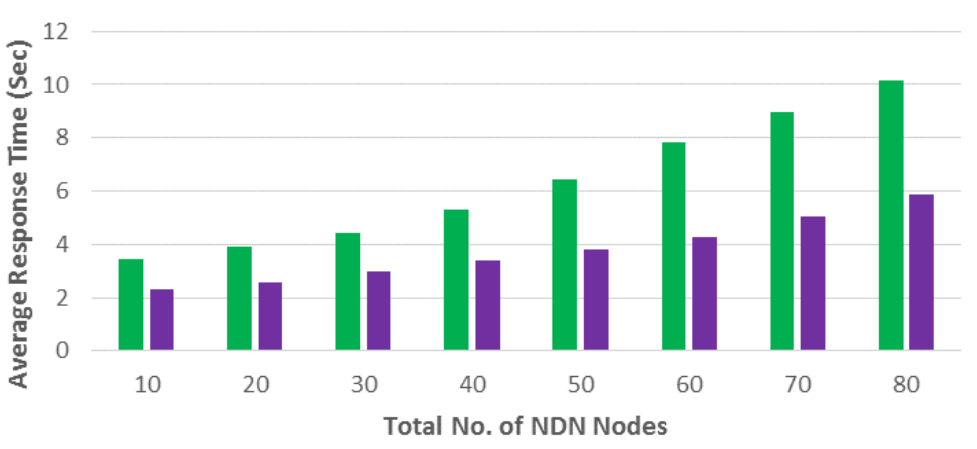
Figure 6. Nodes average response time in wildfire scenario.